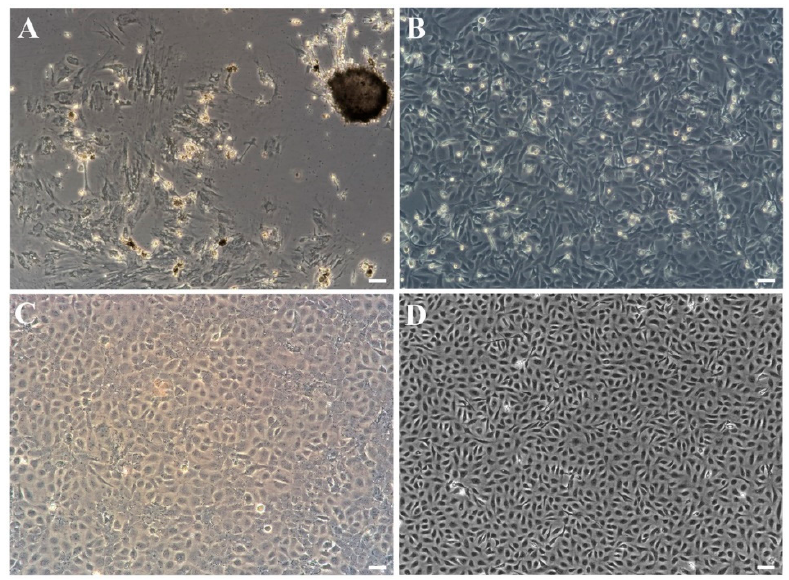
Figure 1. Morphology of the Japanese flounder spleen (JFSP) cells. ( A – D ) Morphology of JFSP cells at Primary passage ( A ), passage 40 ( B ), passage 60 ( C ), and passage 80 ( D ). Scale bar = 50 μ m.